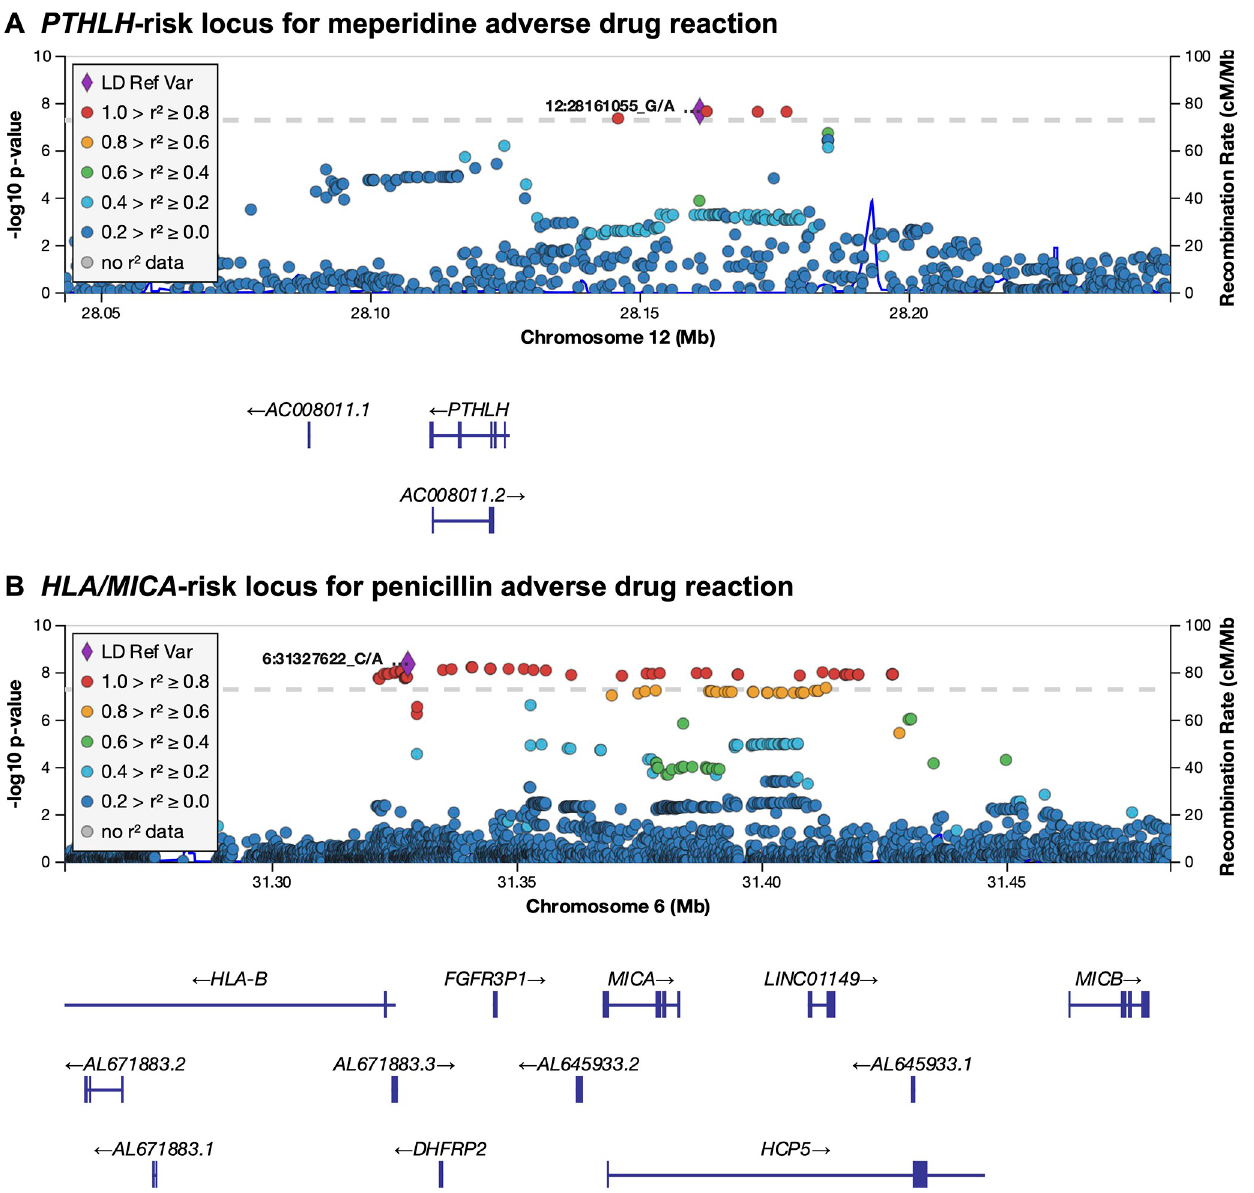
Fig 2. Risk loci for meperidine ( a ) and penicillin ( b ) adverse drug reactions (ADRs). SNPs are colored according to their linkage disequilibrium (LD, based on 1000 Genome phase3 EUR reference panel) with the lead variants rs11049274 (12:28161055) for meperidine ADRs and rs115200108 (6:31327622) for penicillin ADRs, which are marked with a purple diamond. Dotted gray line shows the genome-wide significance level ( P < 5.0 × 10 − 8 ).